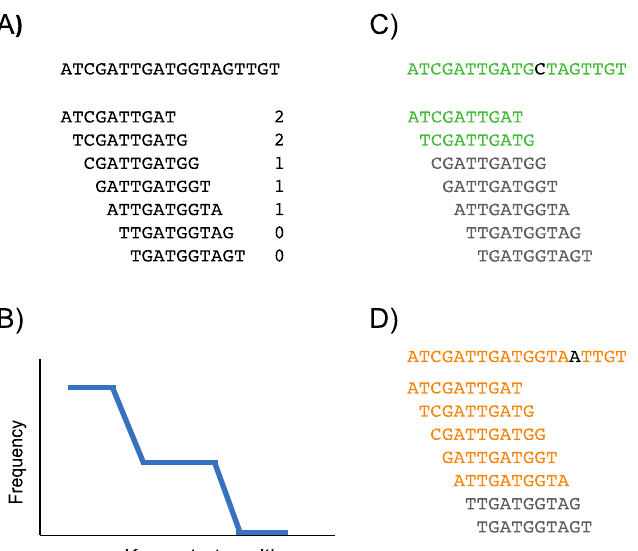
Figure 1. Schematic representation of the construction of a conservation landscape. ( A ) A reference genome and some of its reference kmers are shown. The numbers in front of each kmer are the number of target genomes that contain each kmer. The target genomes that were considered to generate this conservation landscape are shown in ( C , D ). ( B ) The graphical representation of the information presented in ( A ). ( C ) A target genome is shown in green. This genome has a G to C mutation that is shown in black. Each reference kmer is looked for in the target genome. The found reference kmers are shown in green and the missing reference kmers are shown in gray. ( D ) Same information is shown for a different target genome depicted in orange. This genome has a G to A mutation .